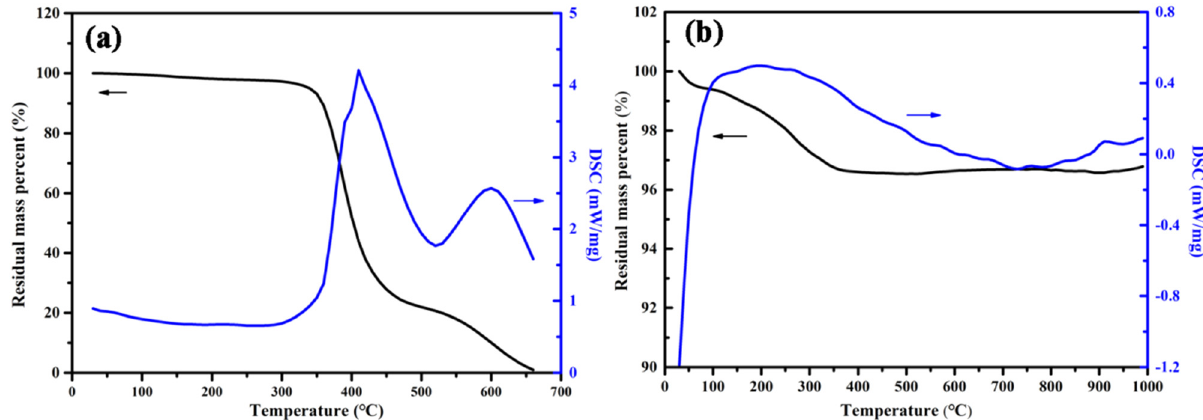
Figure 4: TG and DSC curves of epoxy resin ( a ) and quartz fi ber ( b )